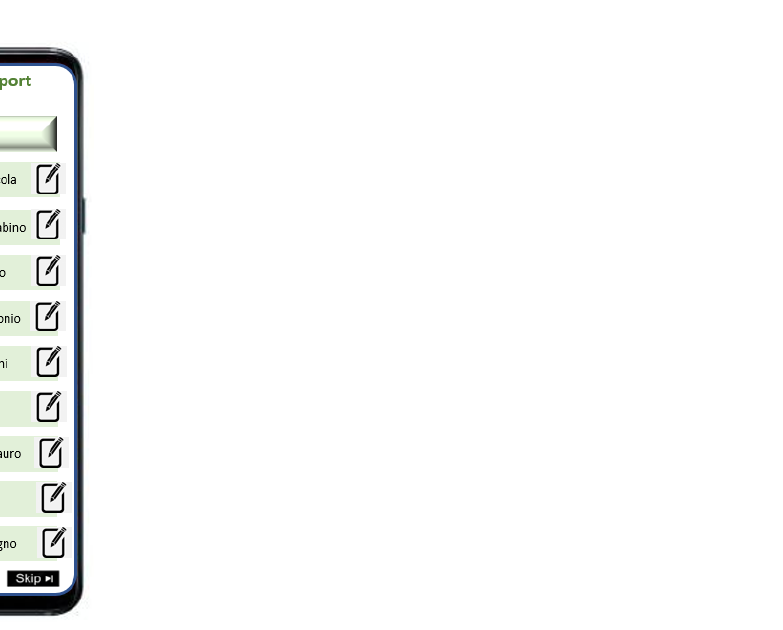
Figure 12. The GUI showing the travel times in the PoIs network from museo Nicolaiano. Preferred transport mode can be edit.